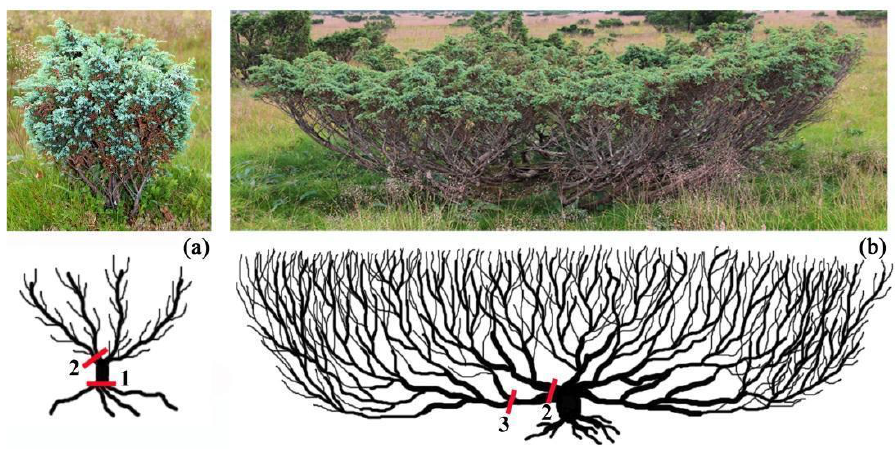
Figure 4. Age determination diagram for young ( a ) and mature ( b ) individual plants of J. sibirica showing the saw-cut lines: 1 — near the hypocotyl, 2 — in the area where the stem splits into plagiotropic branches, and 3 — in other areas of the plagiotropic branch.